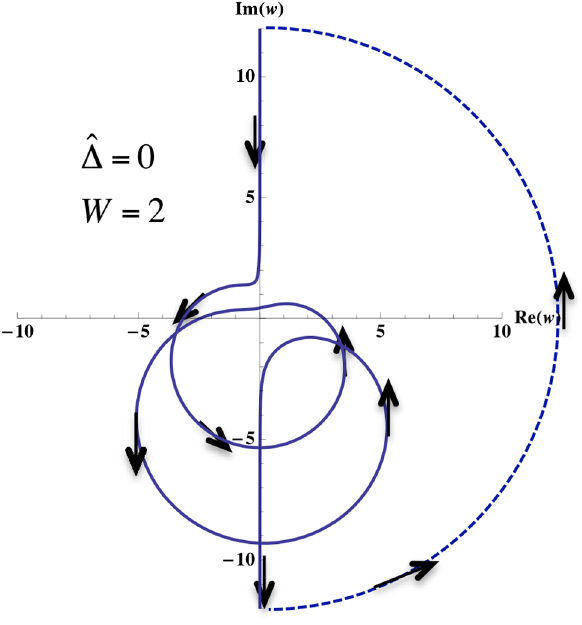
FIG. 7. Contour of w ð C Þ (with scaled down semicircle) for zero detuning ^(cid:2) ¼ 0 .